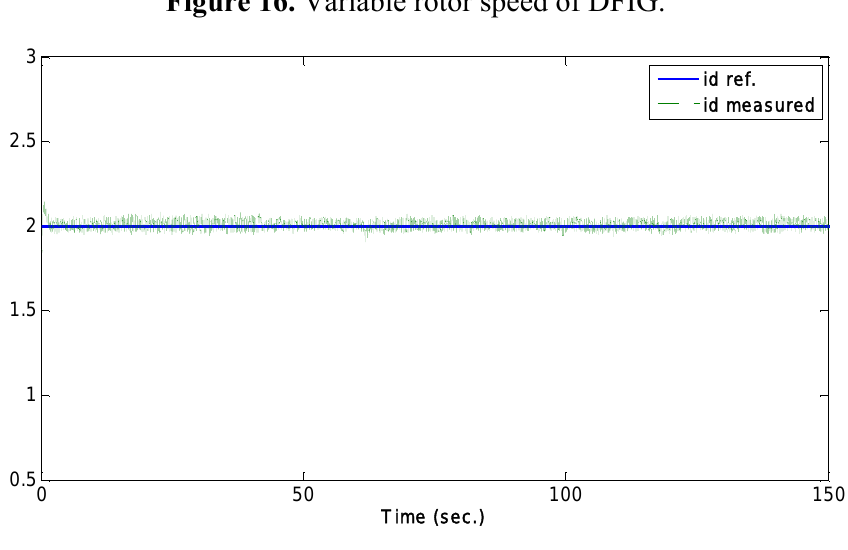
Figure 16. Variable rotor speed of DFIG.